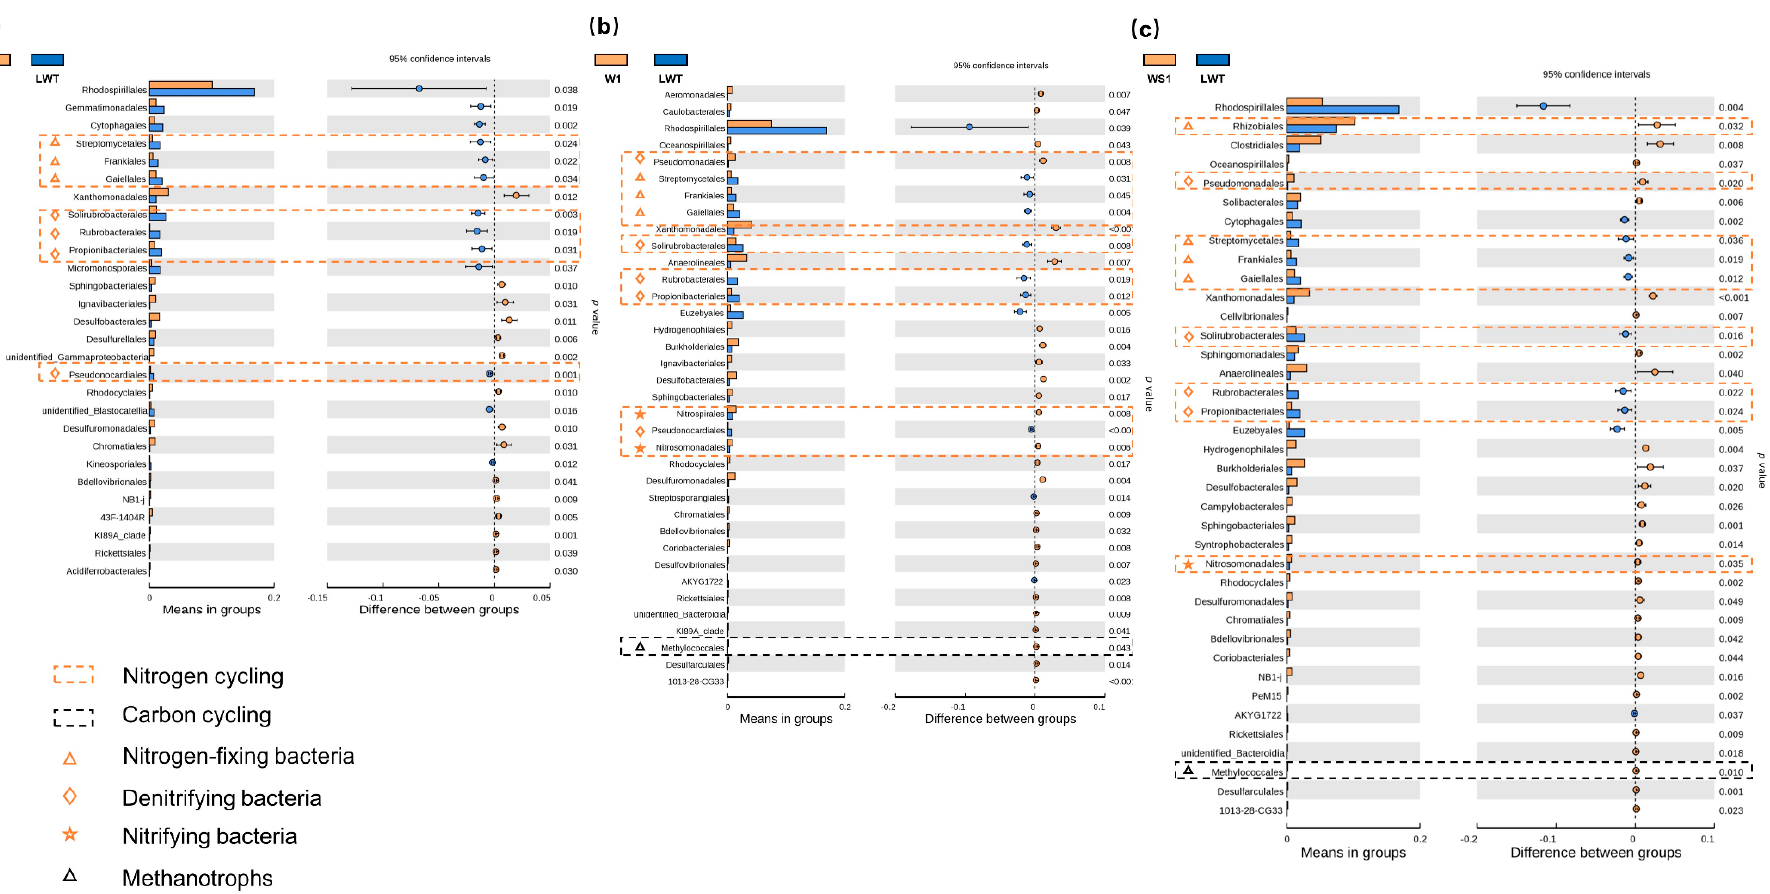
Figure 3. A comparison of the relative abundance of two soil bacterial groups between restored and degraded Phragmites wetlands at the level of bacterial orders. ( a ) comparison between L1 and LWT sites; ( b ) comparison between W1 and LWT sites; ( c ) comparison between WS1 and LWT sites. The significance of the differences between the two groups was determined using the t -test with 95% confidence intervals. The orange and black dashed boxes represent typical bacteria involved in nitrogen and carbon cycling, respectively. Nitrogen-fixing, denitrifying, and nitrifying bacteria are marked by orange triangles, diamonds, and pentacles, respectively. Methanotrophs are marked by black triangles.